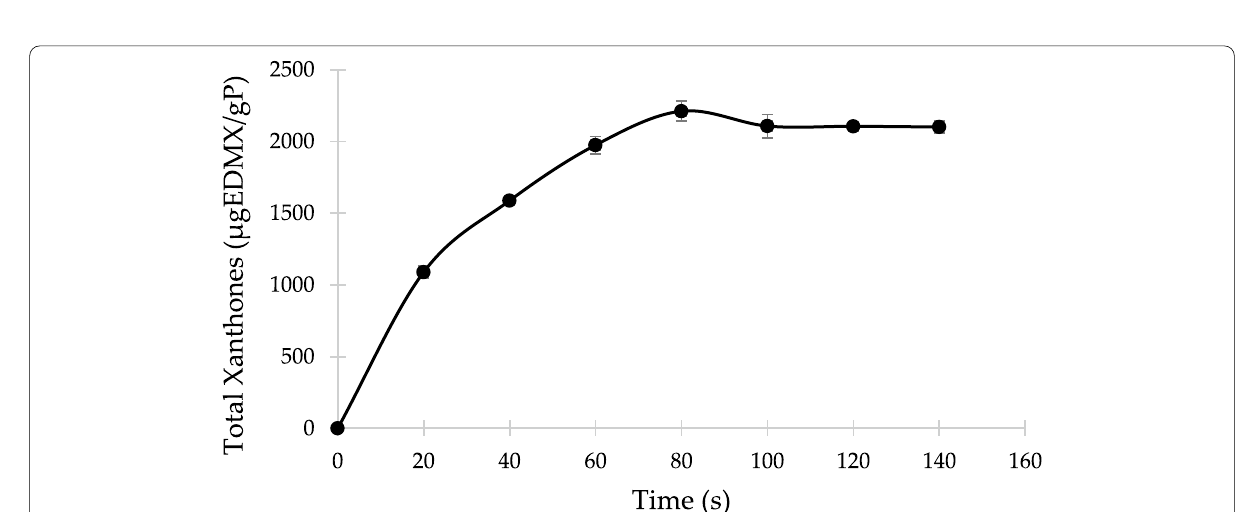
Fig. 1 Effect of extraction time on the concentration of xanthones during microwave-assisted